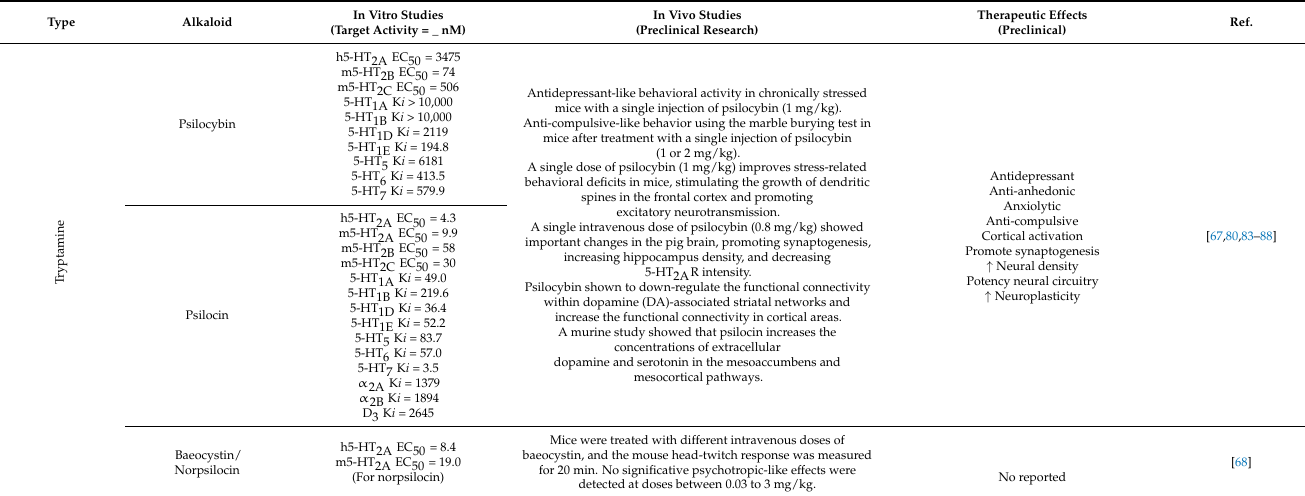
Table 5. Preclinical pharmacological activity of natural-derived indole alkaloids related to neuropsy- chiatric